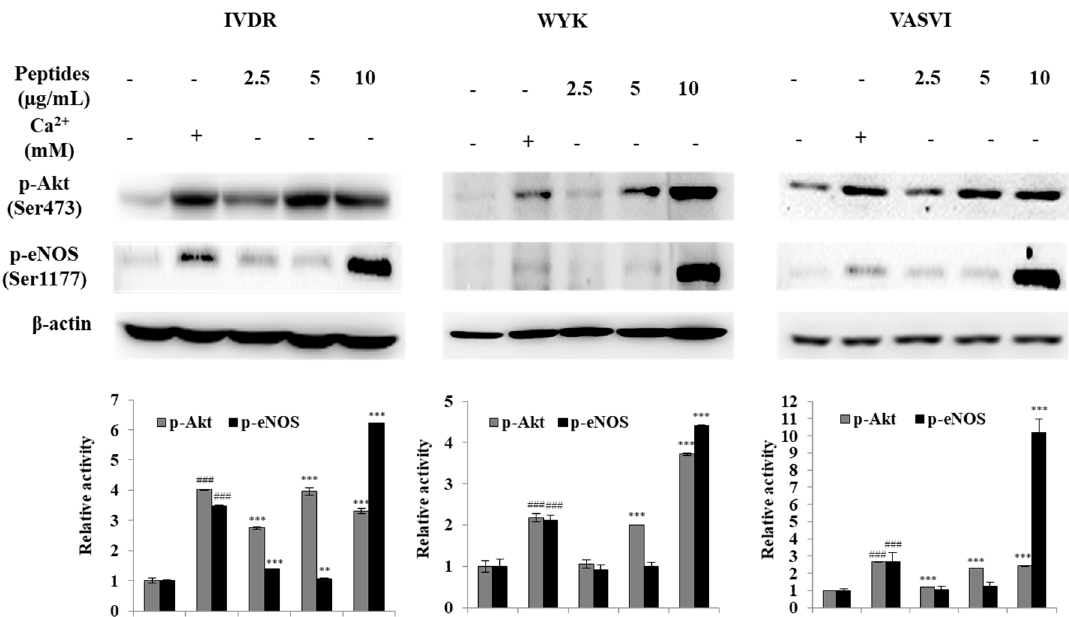
Figure 2. Akt / eNOS phosphorylation level was determined via Western blot analysis in endothelial cells treated with the peptides. The values are means ± SD of triplicate experiments. ### p < 0.001 (positive control compared to non-treated group), ** p < 0.01, *** p < 0.001 (sample group compared to non-treated